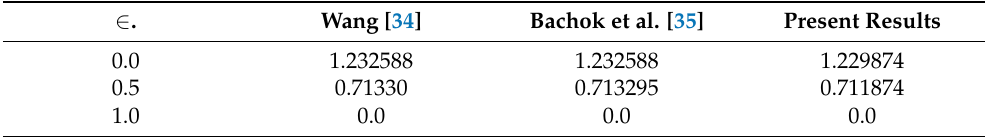
Table 5. Comparative results of Wang [34] and Bachok et al. [35] with existent outcomes when the rest of the physical parameters are